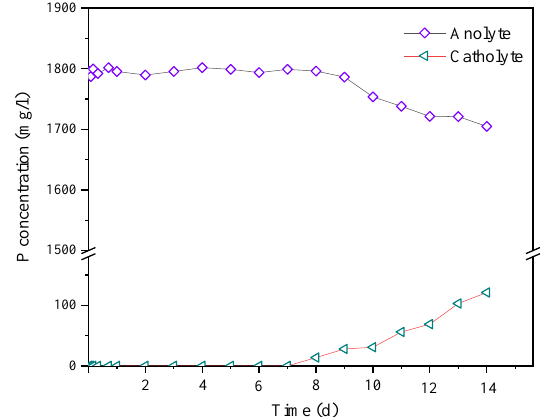
Figure 5. P transformation (mg/L) from anolyte to catholyte.